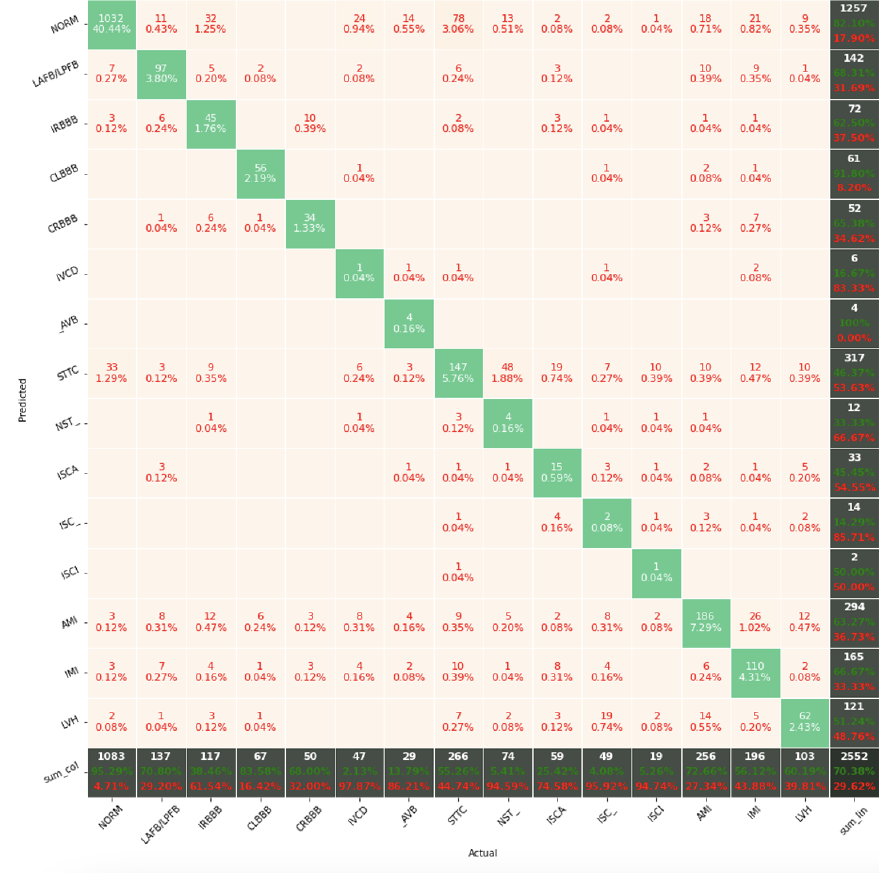
Figure 19. Confusion matrix of the best model in classification for 15